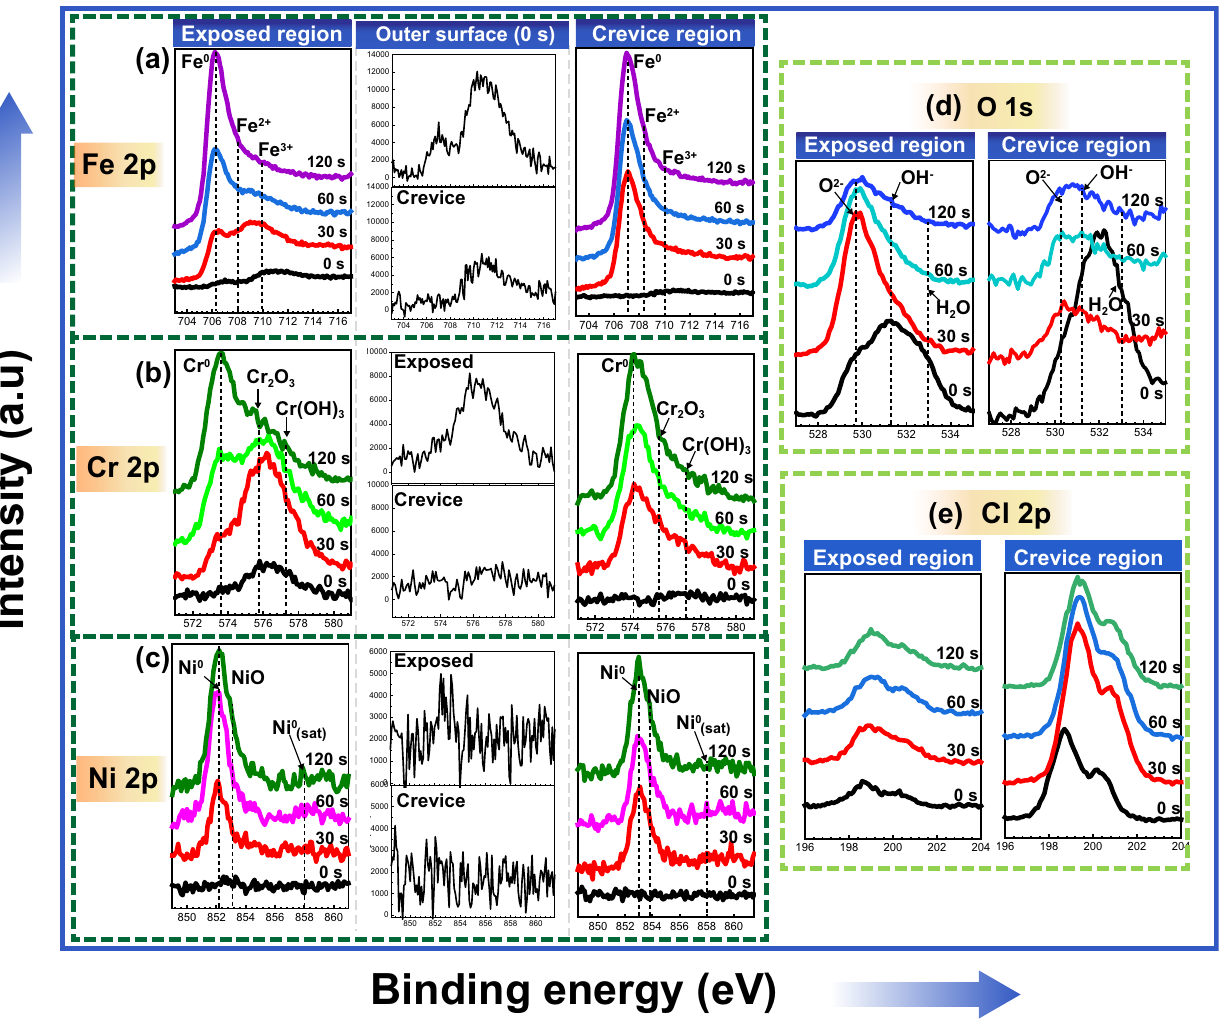
Fig. 5 XPS spectra obtained at the exposed surface and crevice surface as a function of sputtering times. a Fe 2p, b Cr 2p, c Ni 2p, d O 1 s and e Cl